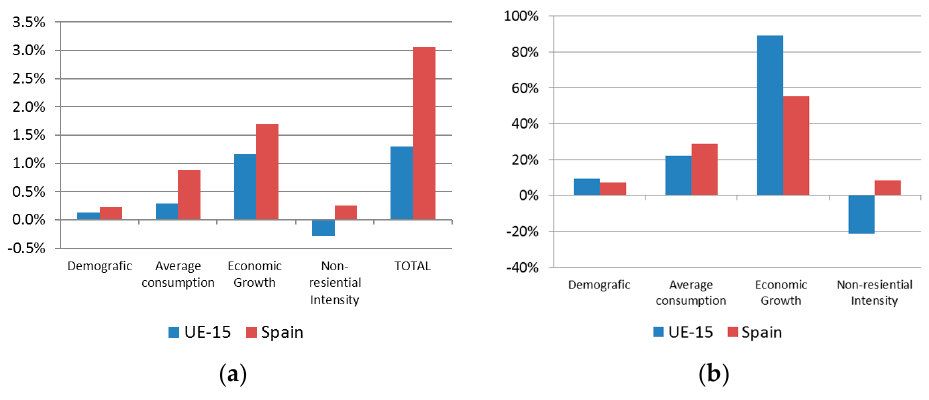
Figure 3. Break down of the consumption growth: ( a ) absolute effects (1990–2012); and ( b ) relative effects (1990–2012). Source: Own calculations with Eurostat data.